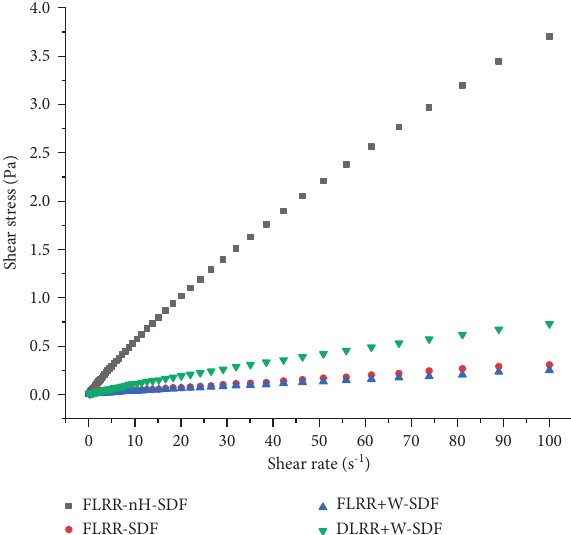
Figure 3: Shear stress versus shear rate profiles of FLRR-nH-SDF, FLRR-SDF, FLRR +W-SDF, and DLRR+ W-SDF from LRRs. Table 5: Rheological properties of FLRR-nH-SDF, FLRR-SDF, FLRR +W-SDF, and DLRR +W-SDF samples from LRRs. Sample K (Pa · s n ) R 2 FLRR-nH-SDF Values are means ± SD of triplicates. Values in the same column with different superscripts are significantly different ( p < 0.05).